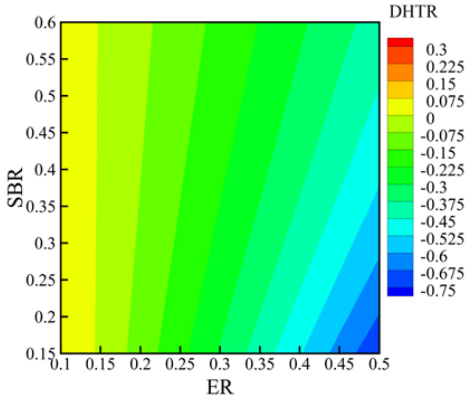
Figure 19. Dimensionless heat transfer ratio (DHTR) distribution at T = 900 K.